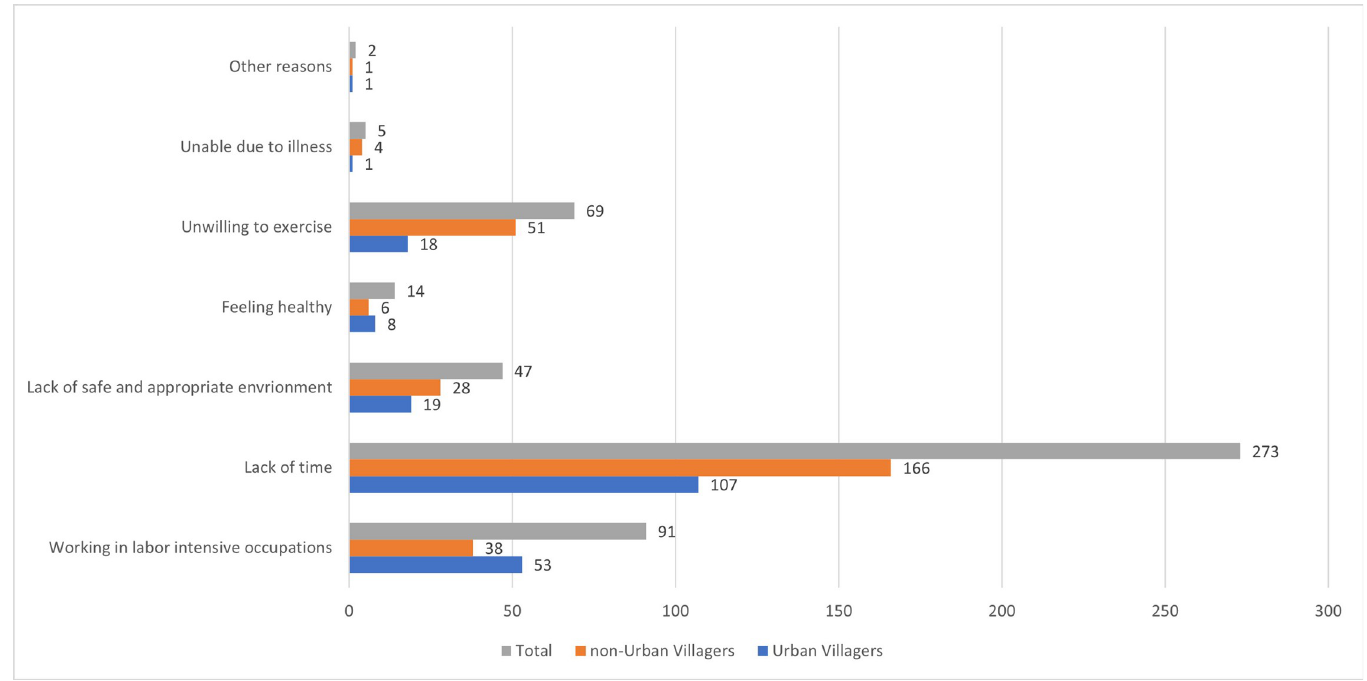
Fig 2. Reasons for not engaging in physical activity among urban villagers and non-urban villagers who engage in physical activity.